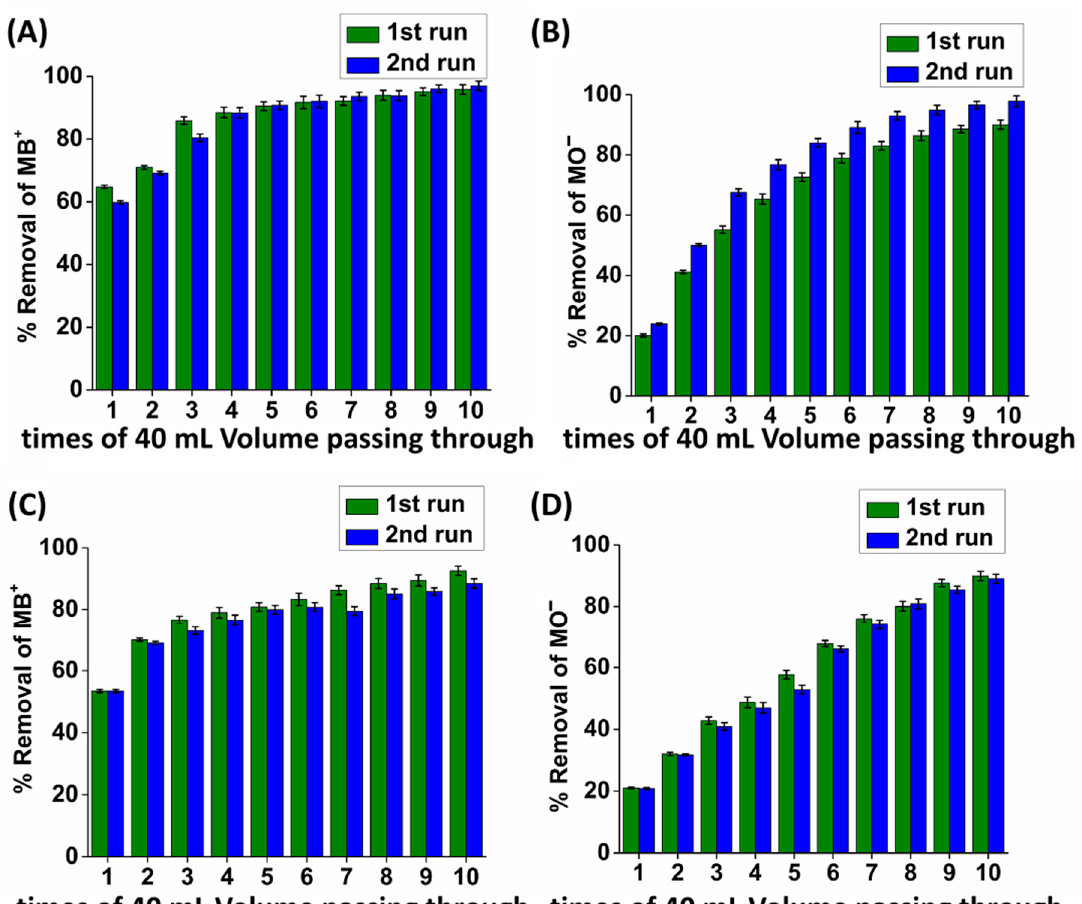
Figure 10. Column sorption data regarding the removal of ( A ) MB + and ( B ) MO − with (MOR- 1/Bentonite/Fe 3 O 4 )-10%CA from the mixture solution. Column sorption data regarding the removal of ( C ) MB + and ( D ) MO − with ( Μ OR-1/Clinoptilolite/Fe 3 O 4 )-10%CA from the mixture solution. The MB + /MO − mixture solution circularly passed through the column up to 10 times.